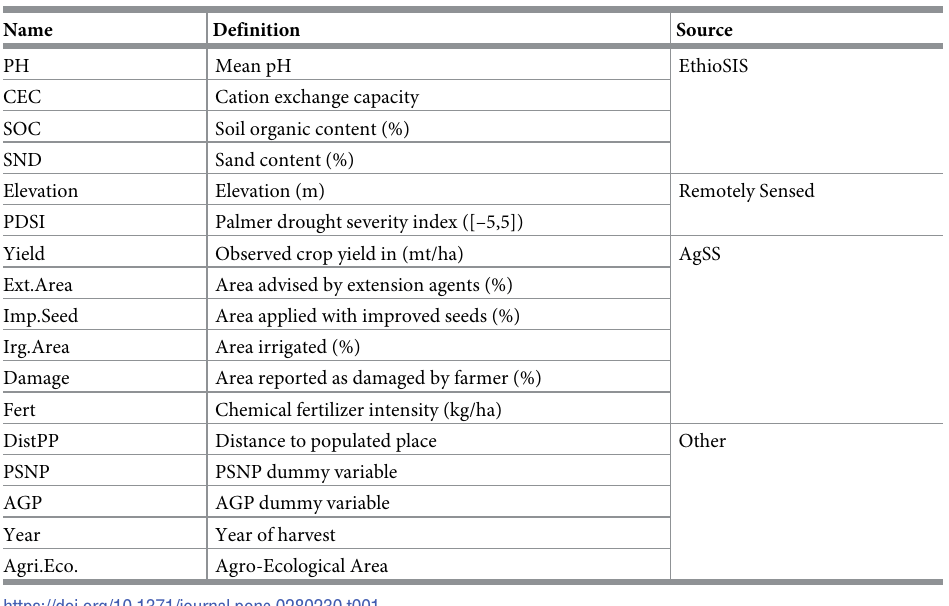
Table 1. Variable definitions and